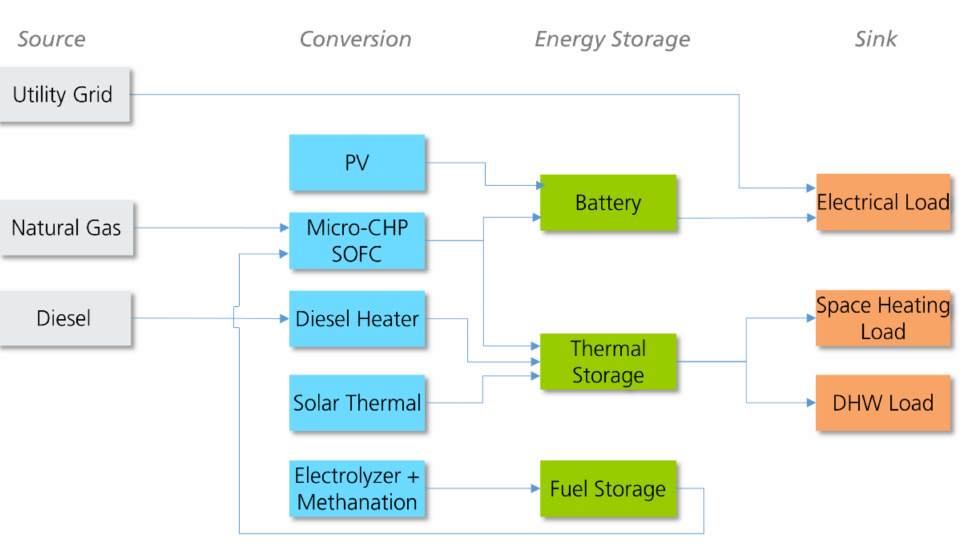
Figure 5. Hybrid power system (HPS) model showing all the integrated components to the